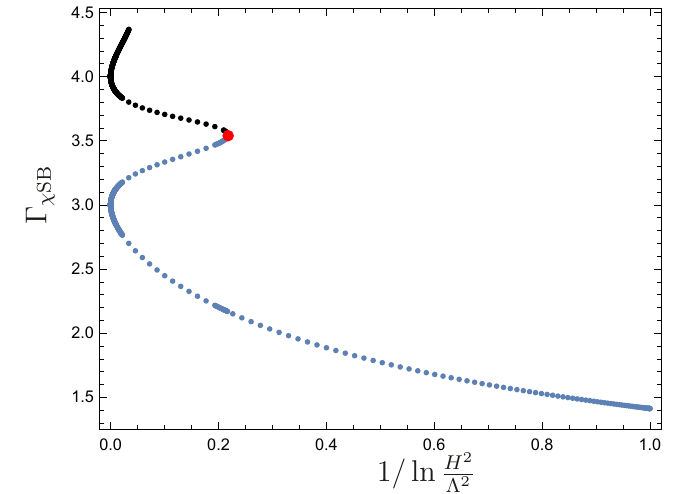
Figure 5 . Sub-branches of the distinct in the conformal limit branches of the fluctuations coalesce as is lowered. The red dot, see (4.5), highlights this phenomenon for n = 4 and n = 3 H Λ